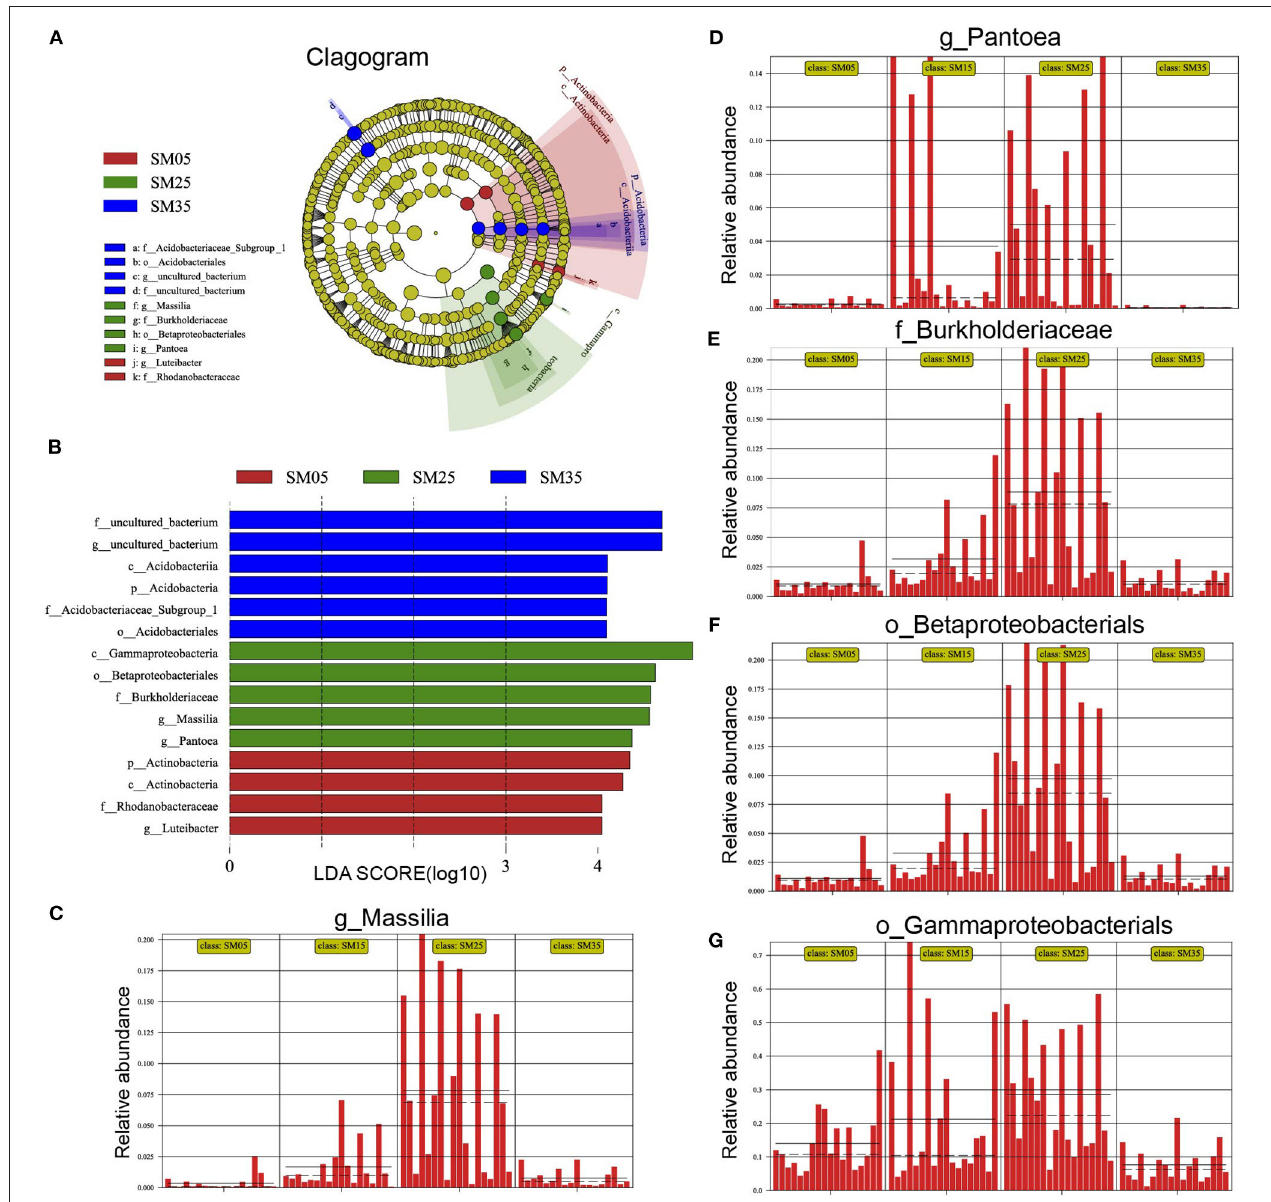
FIGURE 4 | The linear discriminant analysis (LDA) effect size (LEfSe) analysis of bacterial taxa showing significant differences in relative abundance among Chinese fir stands of different ages. (A) Cladogram using LEfSe method indicating the phylogenetic distribution of phyllosphere bacterial communities among different ages; (B) LDA scores showed the significant bacterial difference among four ages; (C–G) the relative abundance of Massilia, Pantoea, Burkholderiaceae, Betaproteobacteriales, and Gammaproteobacteria in each sample from the four groups. SM5, SM15, SM25, and SM35 represent stand ages of 5, 15, 25, and 35 years,